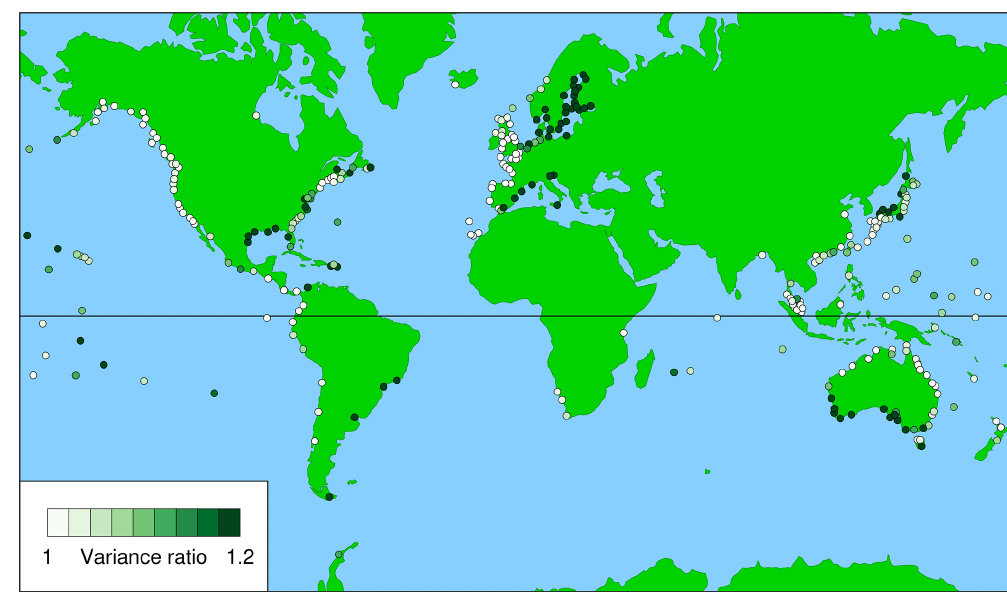
Figure 10. Ratio of variance of observed sea level to variance of predicted tide.